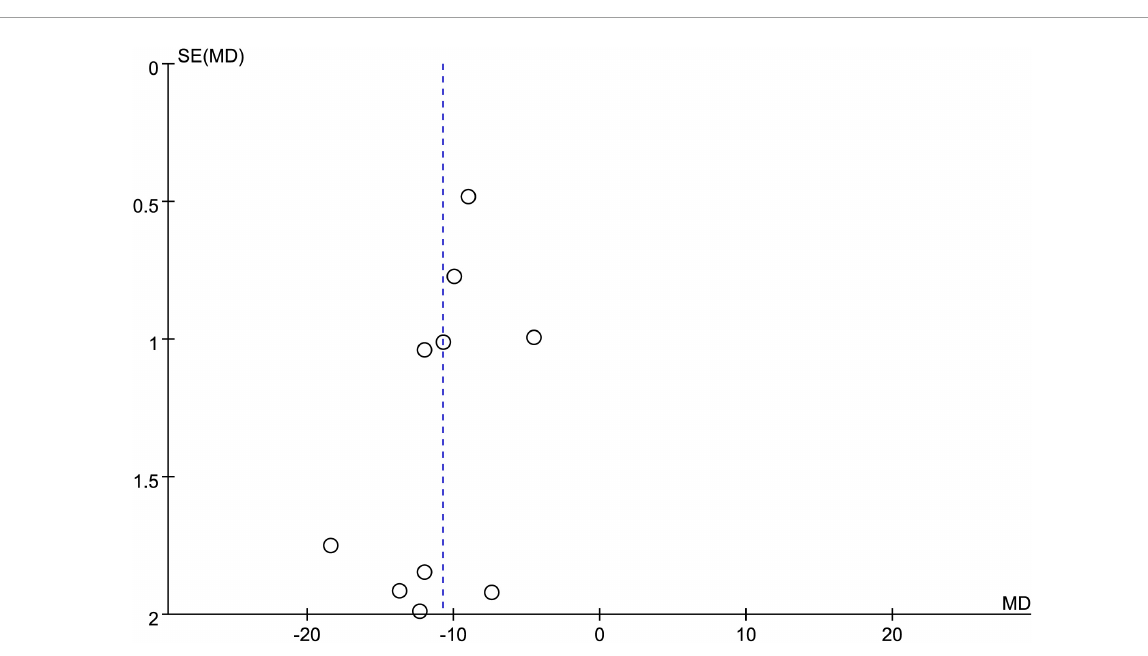
FIGURE8 Funnel plot on the time to pain relief showing a low risk of publication